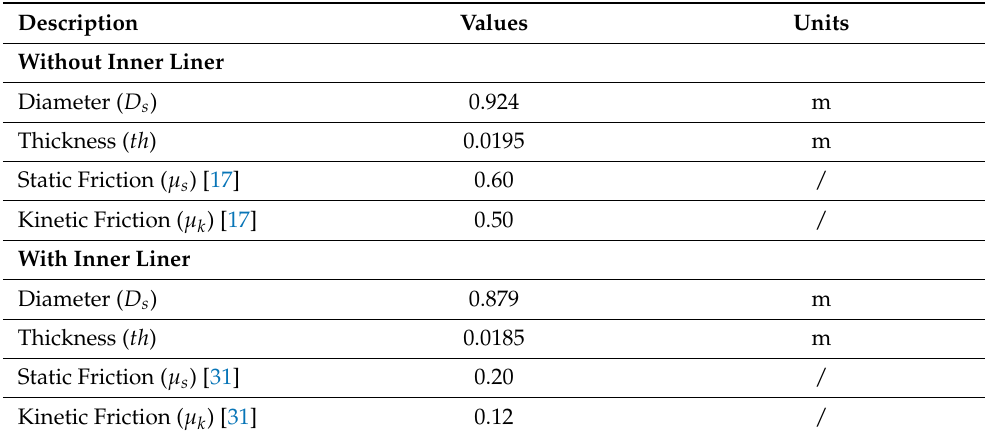
Table 1. Pipeline inspection gauge disc diameter, thickness, static and kinetic friction for the accumu- lators with and without the inner liner.